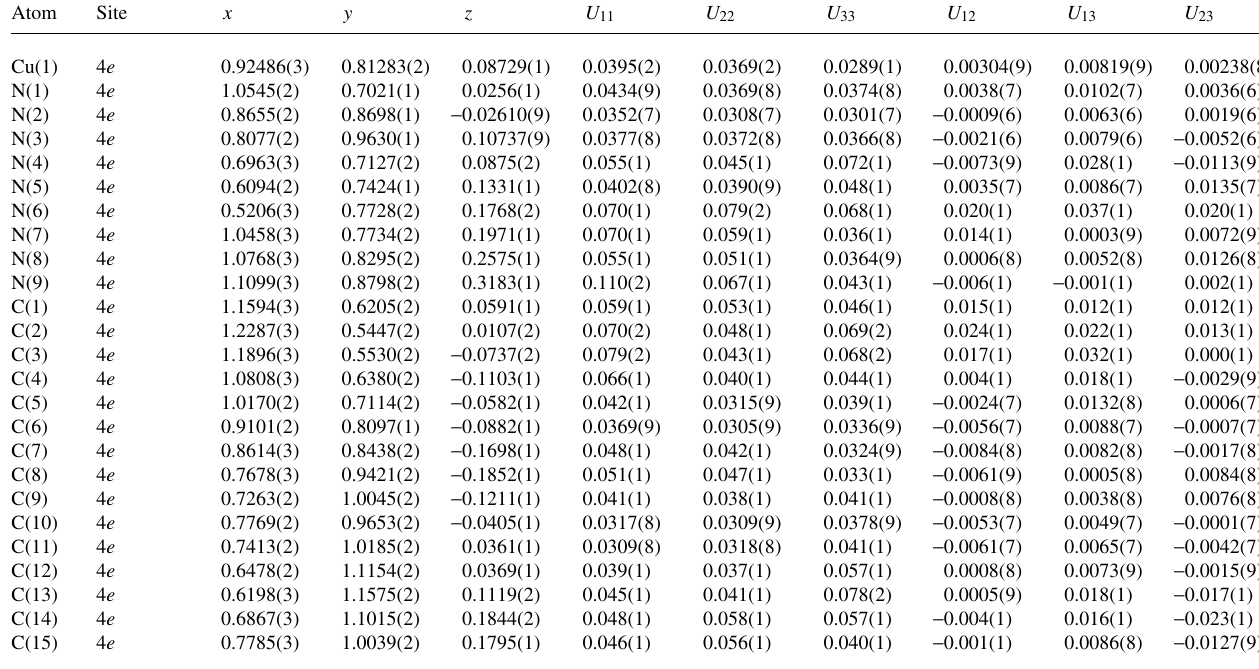
Table 3. Atomic coordinates and displacement parameters (in Å 2 ) .